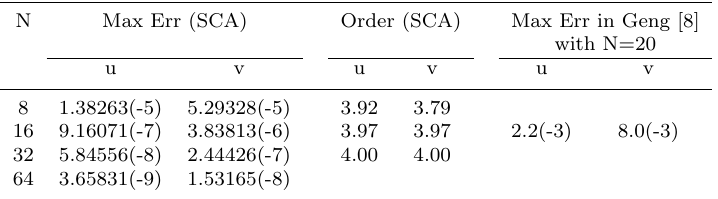
Table 1. Numerical solution of Example 1.